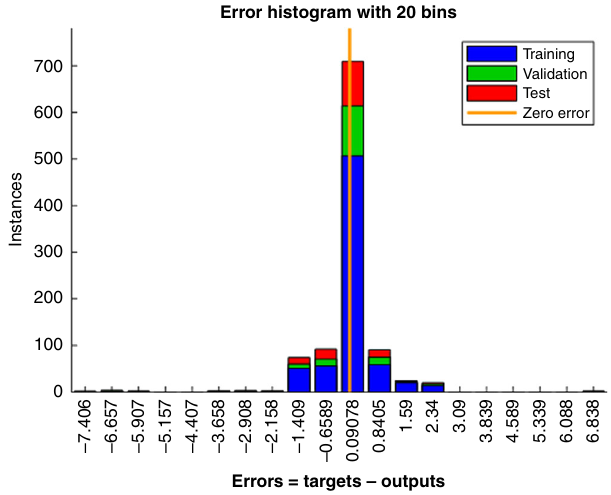
Fig. 7 Machine learning performance in tire pressure monitoring. The error histogram for the tire pressure monitoring algorithm.